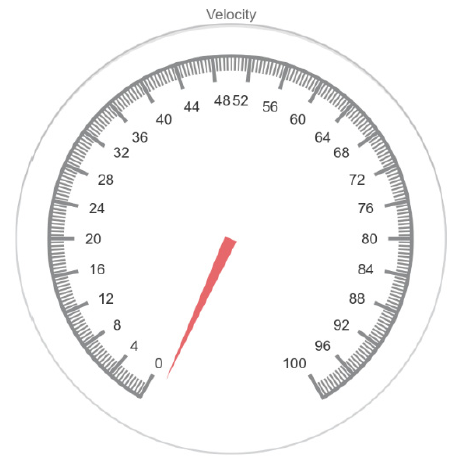
Figure 13. Speedometer to check car speed at run time.